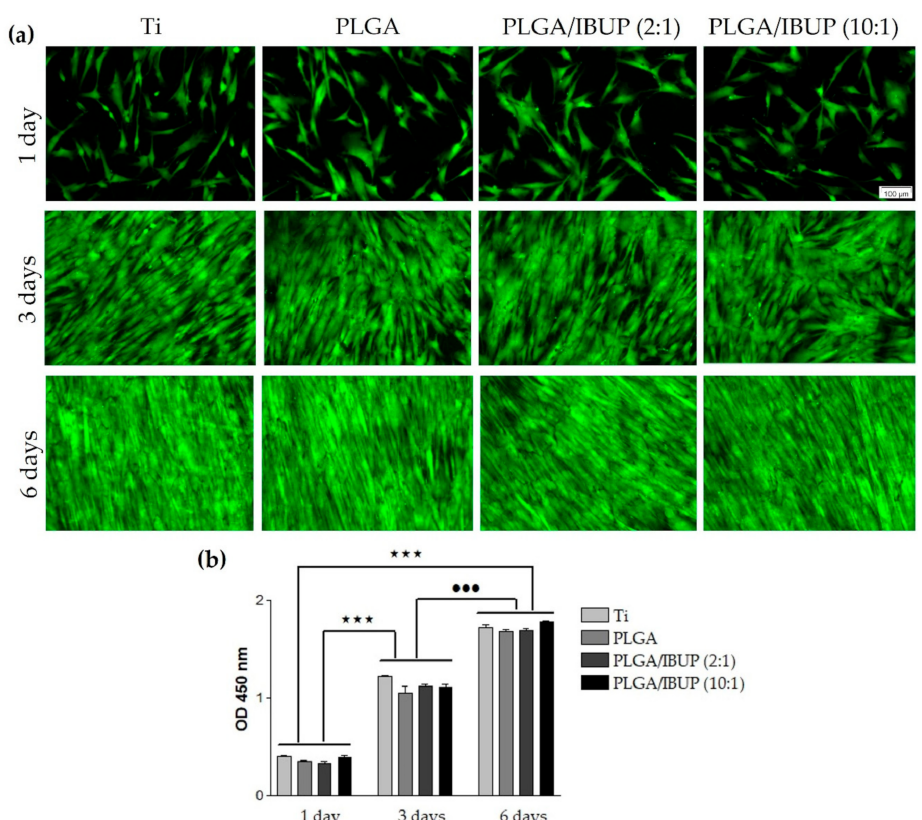
Figure 9. Viability and proliferation of human fibroblasts grown in contact with PLGA-based coatings for 1, 3 and 6 days, evaluated by: ( a ) viable cell fluorescent labeling (Live/Dead assay), scale bar 100 µ m; ( b ) fibroblast proliferative potential (cid:70)(cid:70)(cid:70) p (CCK-8 test); < 0.001; ••• p < 0.001 vs. 3-day time